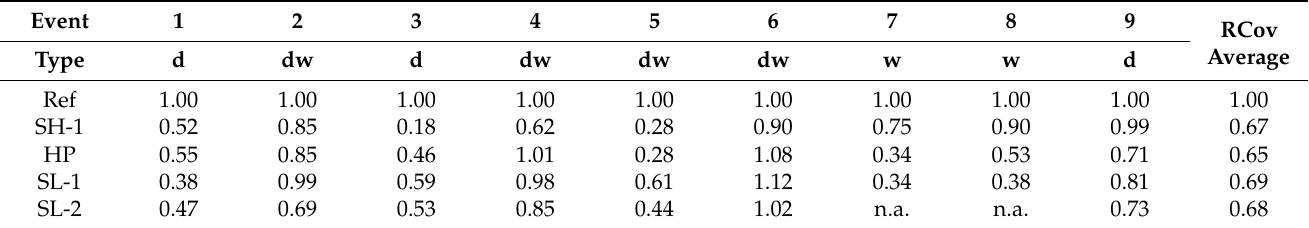
Table 5. Rcov index for the tested samples during the snowfall events. n.a data are not available.